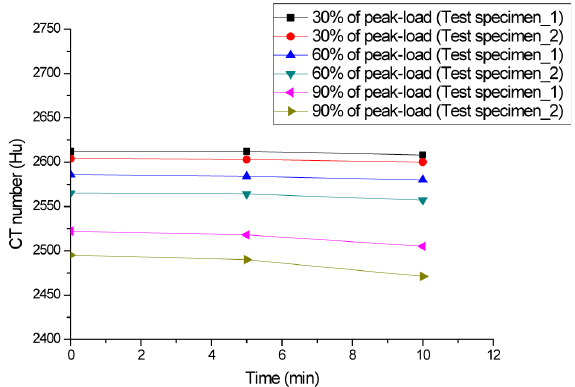
Fig. 5. Time-CT number curves of Test specimen_1 and Test specimen_2 with loads of 30%, 60% and 90% of the predicted peak load value